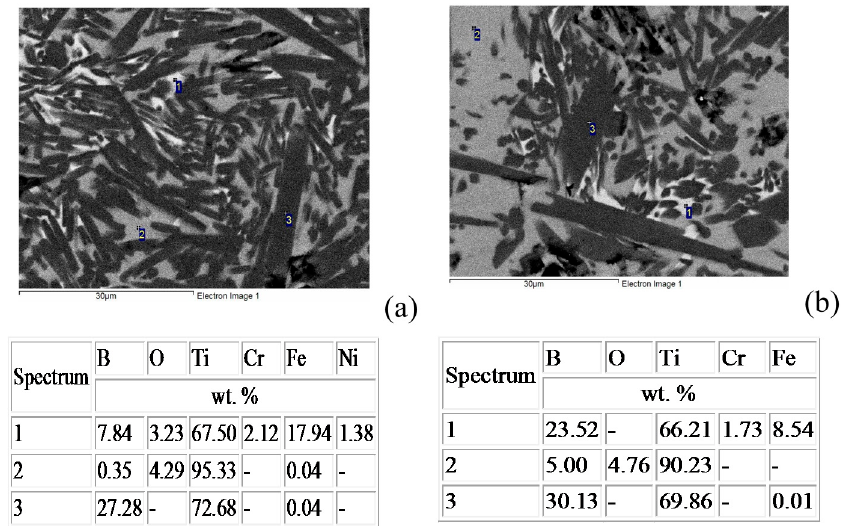
Figure 8. Microstructure and the results of energy dispersive analysis of elements after oxidation at 1100 °C: ( a ) central part and ( b ) sample surface.